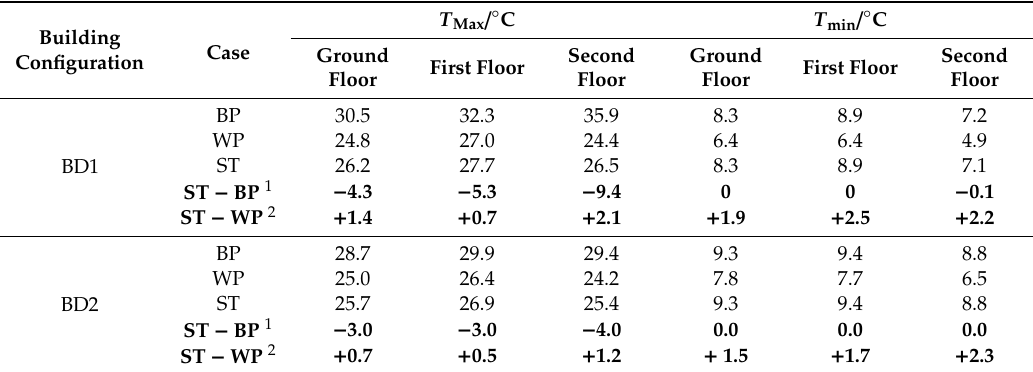
Table 3. Average maximum indoor temperature ( T Max ) over the hottest week of the year and average minimum indoor temperature ( T min ) over the coldest week of the year, for a building painted with an optimized thermochromic step transition paint (ST), located in Porto, Portugal.